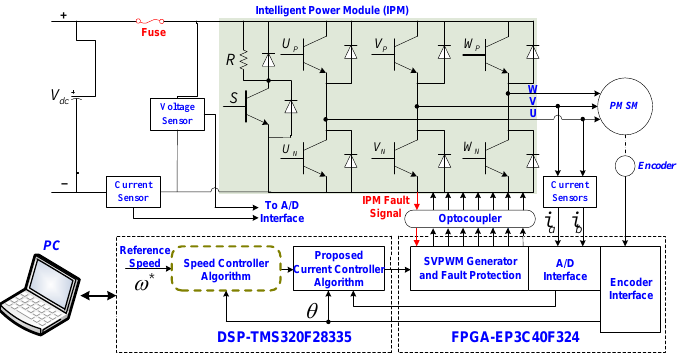
Figure 15. Structural diagram of the PMSM servo system. Figure 14. Photograph of the experimental platform.